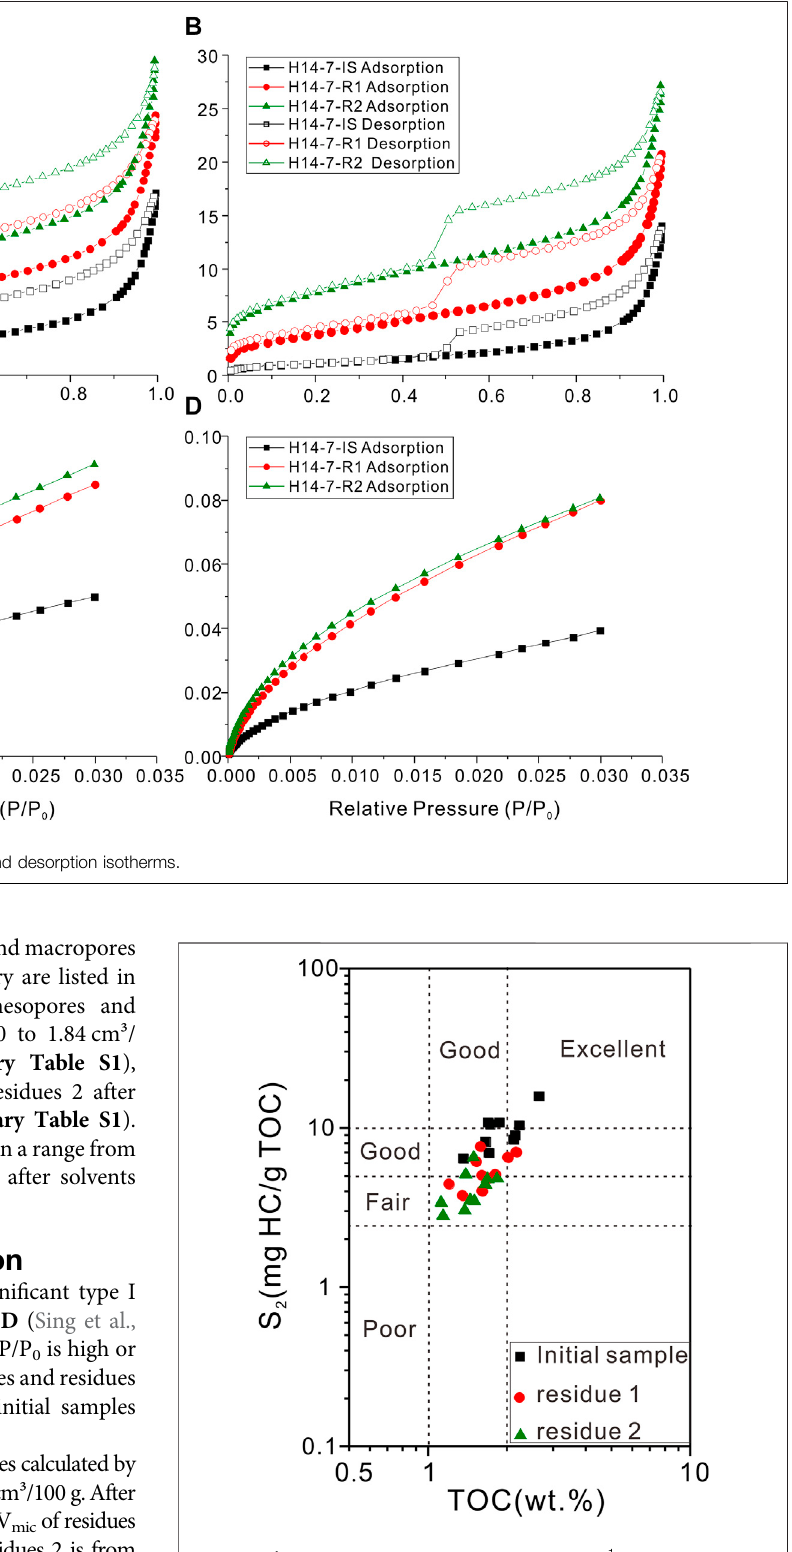
FIGURE6| PlotofTOCandS 2 displayspotentialofK 2 qn 1